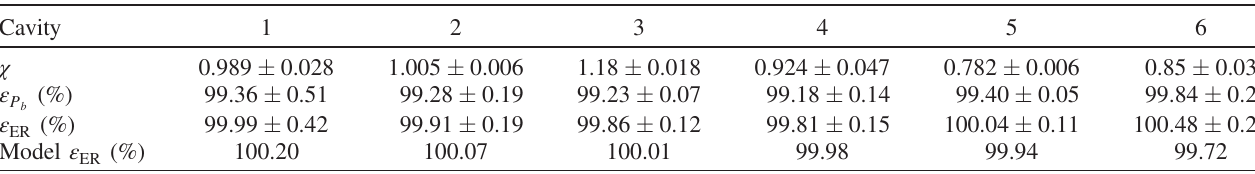
TABLE III. Per cavity measurements and predictions.